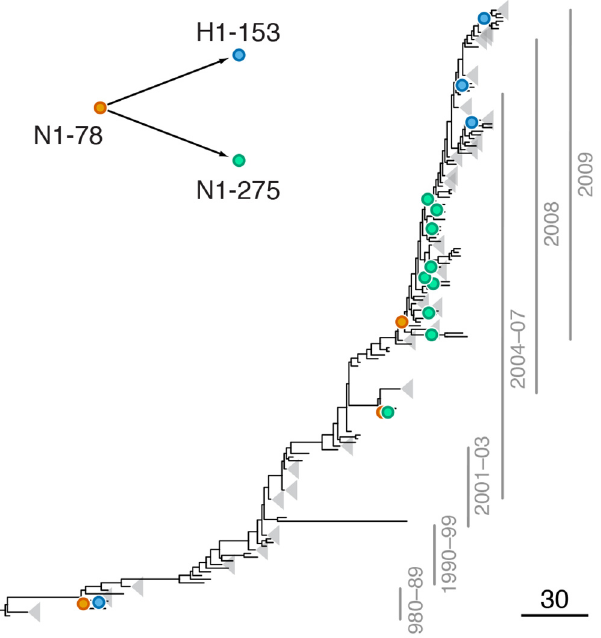
Fig 2. Example of putative inter-gene epistasis between sites N1-78 and H1-153. Mutations at sites N1- 78 and H1-153 are marked by orange and blue circles, respectively; mutations at site N1-275 are marked by green circles. Site N1-275 was found to form a highly scoring intra-gene epistatic pair with site N1-78 in our previous study [21] (see text for details). Only mutations that form consecutive pairs are shown (see Materials and Methods); see S1 Data for all mutations. Vertical bars show years in which the isolates where sampled. The inset shows the inferred directionality of epistatic interactions with arrows pointing from the leading to the trailing